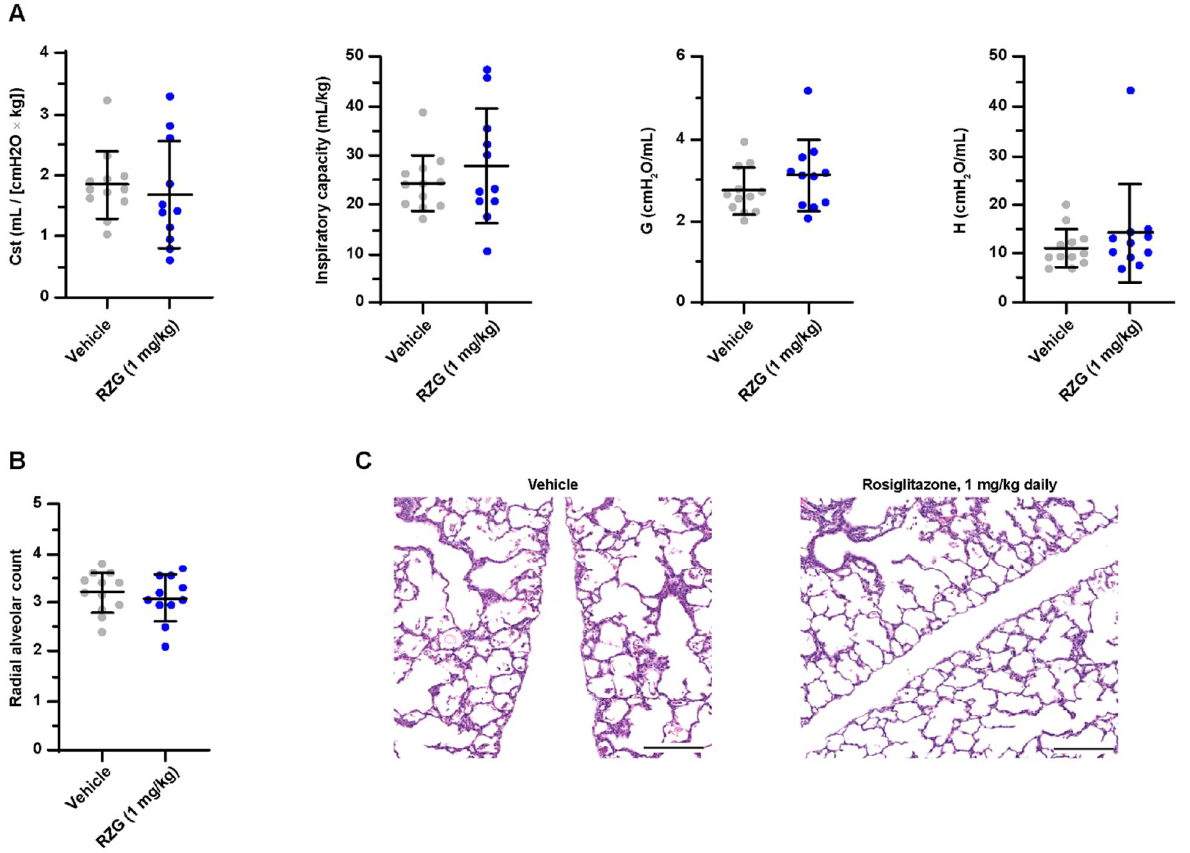
Figure 3. ( A ) Static compliance (C st ), total inspiratory capacity, lung tissue damping (G), and tissue elastance (H) at post-natal day 7 in preterm rabbits exposed to hyperoxia (95% oxygen) treated with daily intraperitoneal rosiglitazone (1 mg/kg) or the vehicle. ( B ) Radial alveolar count and ( C ) representative hematoxylin–eosin-stained lung sections at post-natal day 7 (the scale bar represents 200 µ m). No significant differences were found between groups.